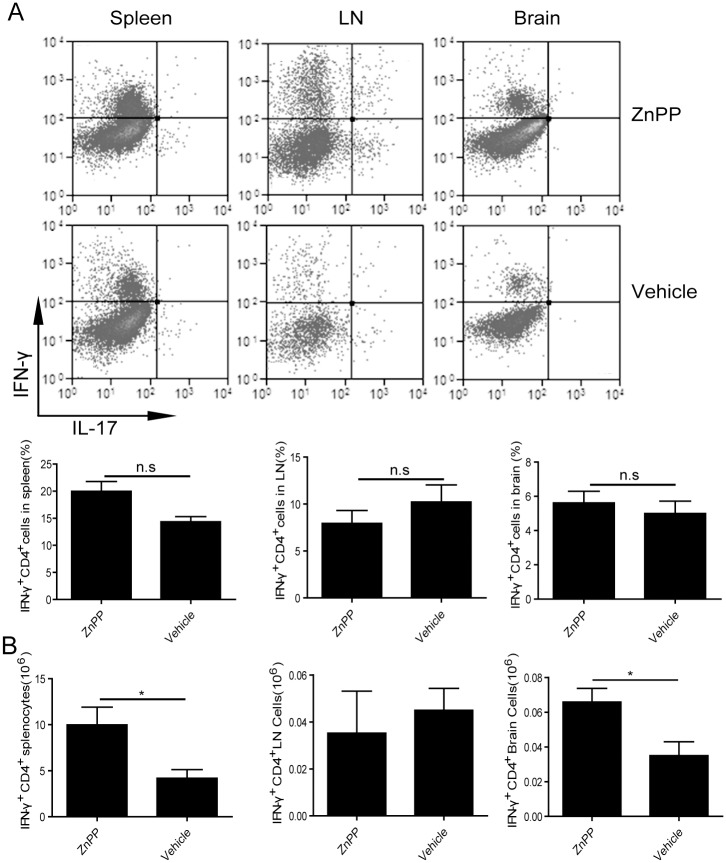
Increased Th1 cells infiltrating the brain of miR-155
-/- mice treated with ZnPP.
MiR-155
-/- CD4+ T cells were transferred in Rag1
-/- congenic recipients one day before EAE induction. Mice received ZnPP treatment or vehicle alone. (A) Flow cytometric analysis of IFN-γ and IL-17 expression in T cells (Gated on CD3 and CD4 double positive cells) from spleen, LN and brain of miR-155
-/- mice immunized with MOG35-55 and treated with ZnPP or vehicle alone. n.s: p>0.05. Data are shown as mean ±SEM. n = 6 mice per group. The results are representative of two independent experiments. (B) Numbers of IFN-γ- or IL-17-producing T cell (Gated on CD3 and CD4 double positive cells) from spleen, LN and brain of miR-155
-/- mice immunized with MOG35-55 and treated ZnPP or vehicle alone. *: p<0.05. Data are shown as mean ±SEM. n = 6 mice per group. The results are representative of two independent experiments.